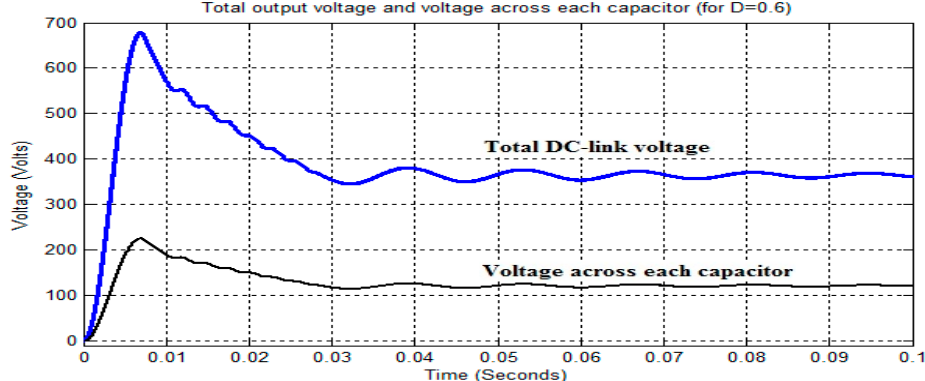
Figure 13. Output of TLBC in open-loop for D = 0.6.